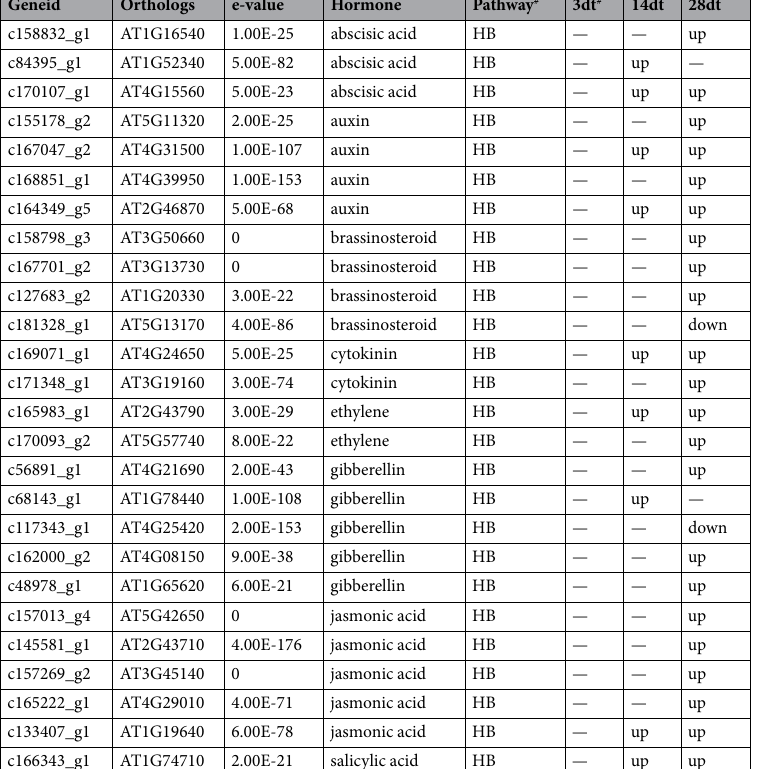
Table 3. The differentially expressed hormone biosynthesis genes. # HB: hormone biosynthesis. # 3dt: 3d treatment. :-Not differentially expressed genes. Up: up-regulated. Down: down-regulated.